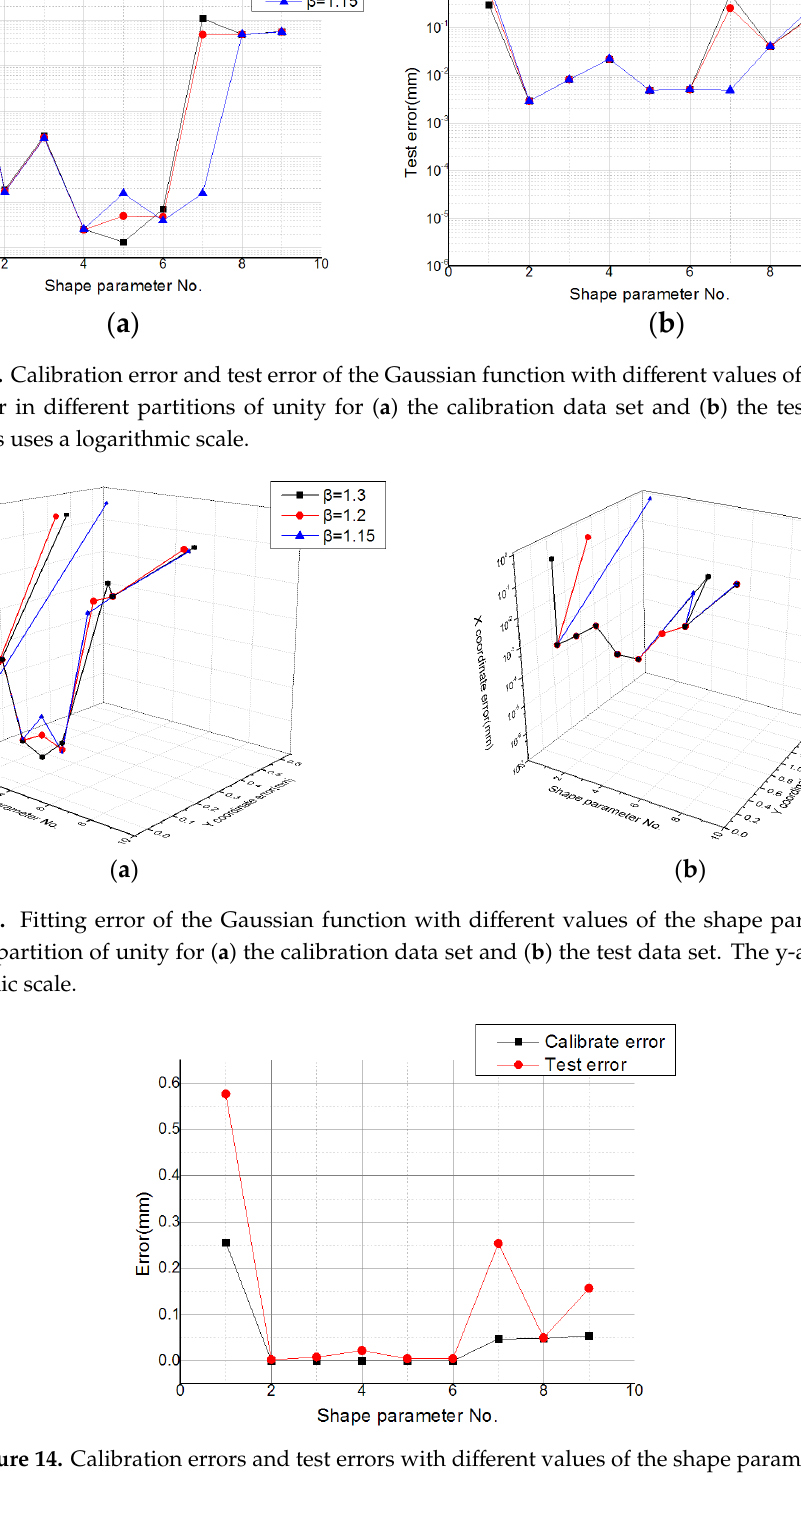
Table 3. Fitting errors with different values of the shape parameter.